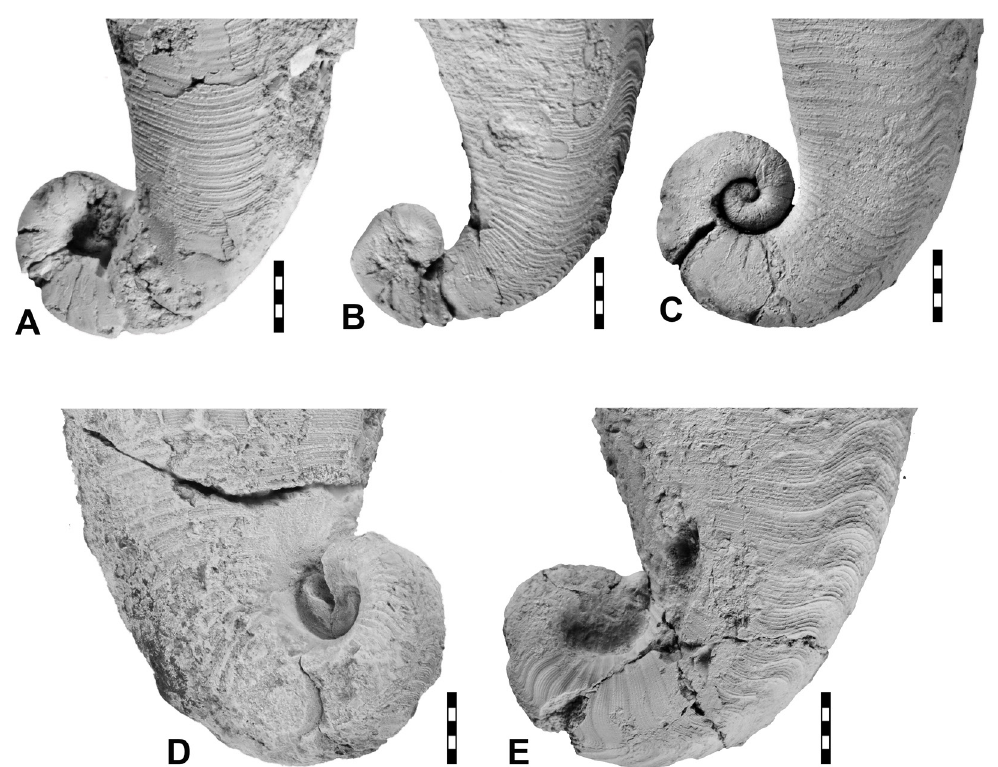
Fig. 23. Comparison of the coiled parts of species of Ancistroceras Boll, 1857 from the Upper Grey Orthoceratite Limestone. A . Ancistroceras barrandei Dewitz, 1880, specimen MB.C.30518 (Neben & Krueger Coll.) from Rerik (Ostsee). B . Ancistroceras barrandei Dewitz, 1880, specimen MB.C.30516 (Neben & Krueger Coll.) from Rerik (Ostsee). C . Ancistroceras barrandei Dewitz, 1880, specimen MB.C.11991 (Helms 1966 Coll.) from Groß Zicker (Island of Rügen). D . Ancistroceras torelli (Remelé, 1881), lectotype MB.C.22575 from Heegermühle (Brandenburg). E . Ancistroceras torelli (Remelé, 1881), specimen MB.C.30519 (Neben & Krueger Coll.) from Schmetzdorf (Brandenburg). Scale bar units = 1